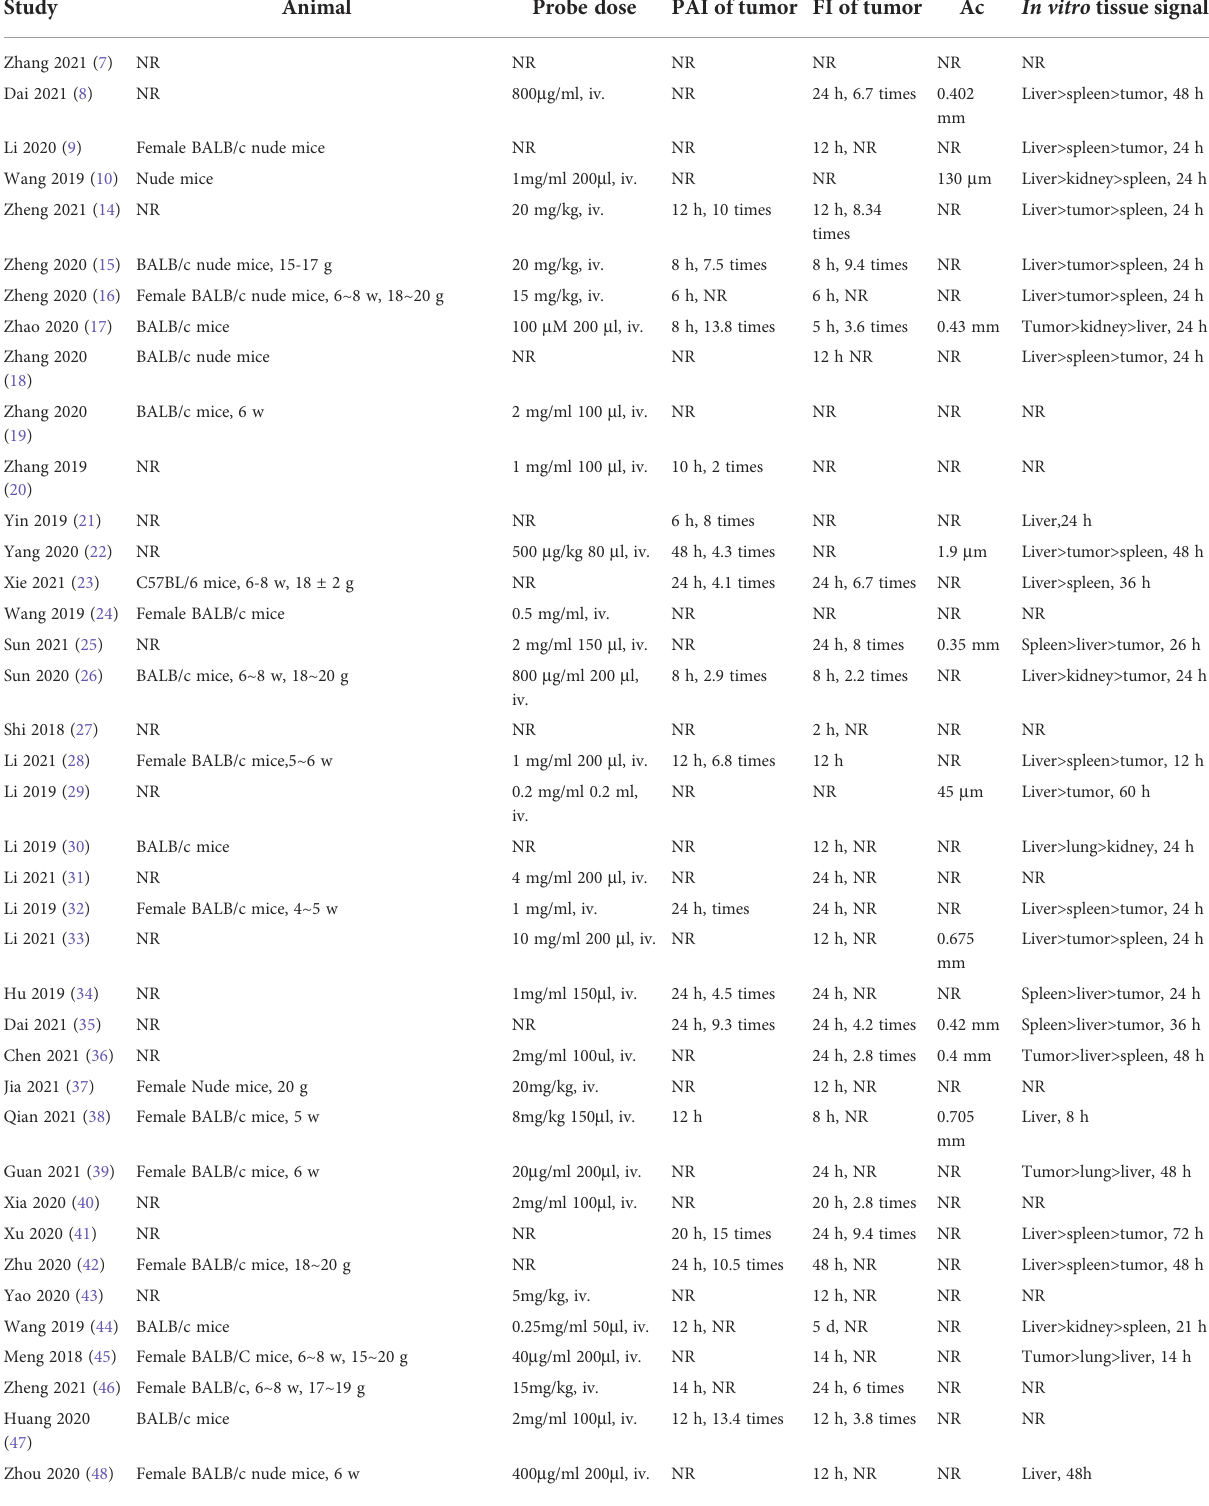
TABLE 2 The characteristic pro fi les of probes for tumor imaging. Study